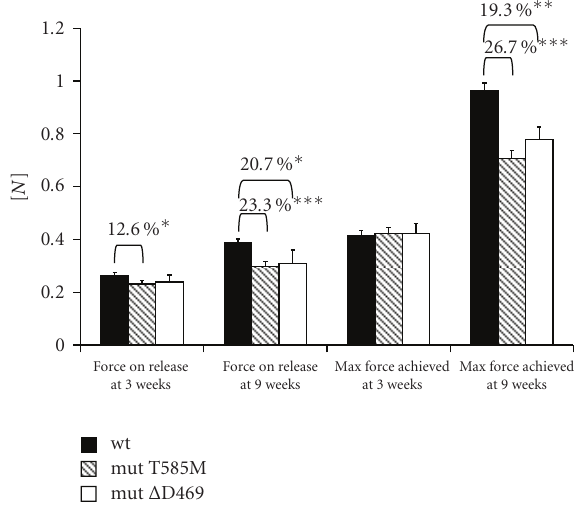
Figure 5: Grip strength measurement in COMP-CTD T585M knock-in mice and COMP-T3 Δ D469 knock-in mice at 3 weeks of age. COMP-CTD mice were getting tired and let go of the apparatus easier than their wild type controls, although they were not generally weaker at 3 weeks of age, as seen by the maximum strengths registered ( n = 15) [71]. COMP (cid:2) D469 mice were not getting tired and had the same maximum strength as the wild type controls at 3 weeks of age; however, by 9 weeks they were significantly weaker than their wild type littermates and tired easier, which is indicative of a mild myopathy ( n = 5). Key: wt: wild type, mut: homozygous for the mutation, ∗ P < . 05, ∗∗ P < . 01, ∗∗∗ P < . 001 (independent samples t